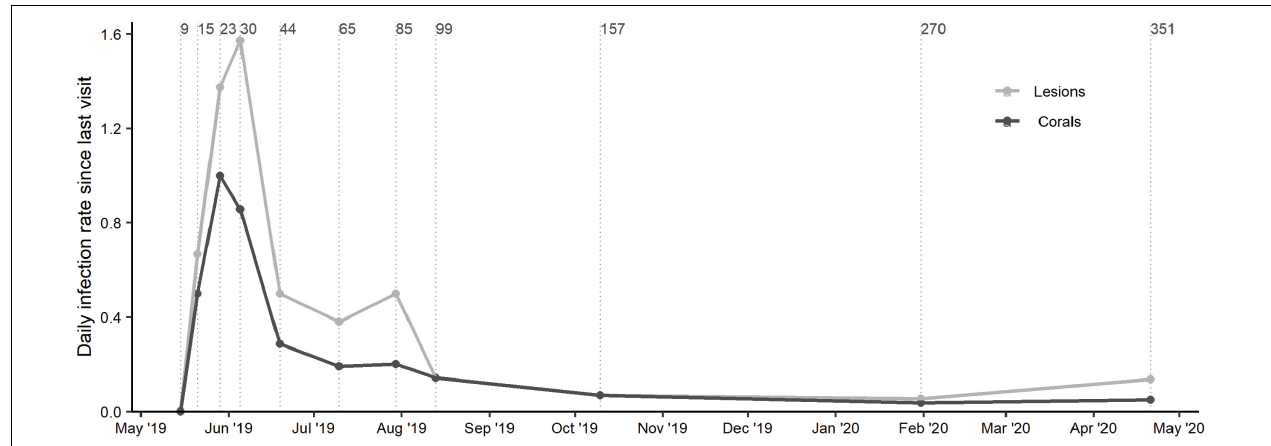
FIGURE 4 | Rates are calculated as the number of new lesions (or new corals)/number of days since last assessed. The rate since last visit of new disease lesions and newly diseased corals. Vertical lines indicate the cumulative number of days elapsed since initial treatments.